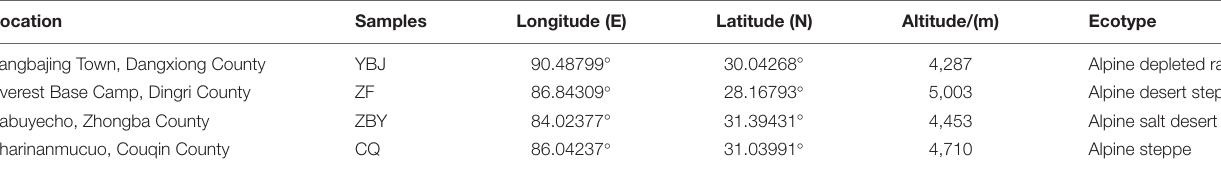
TABLE 1 | Sample site